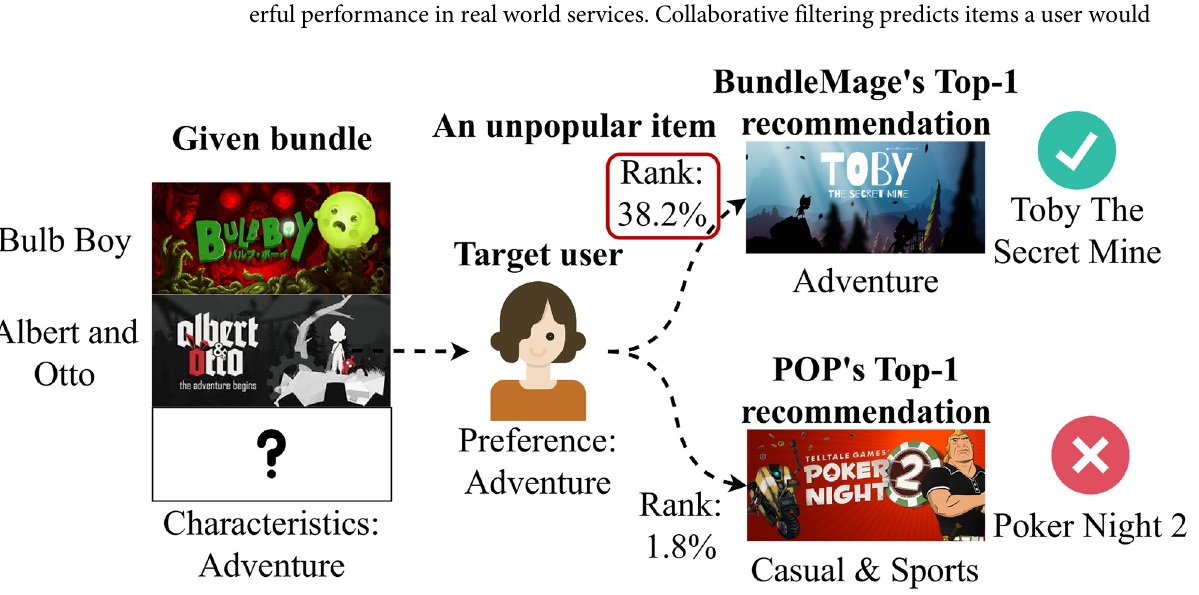
Fig 7. Top-1 recommendations of BundleMage and POP for a target user in bundle generation. B UNDLE M AGE successfully recommends an unpopular item “Toby: The Secret Mine” (ranked in top 38.2%) which is the ground-truth one, whereas POP recommends a popular item “Poker Night 2” (ranked in top 1.8%) which is unrelated to the given bundle and the target